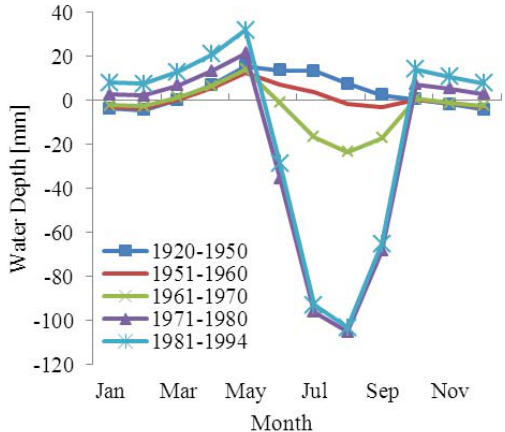
Fig. 8. Monthly aquifer storage change averaged by decades (stor- age change before the 1950s is not simulated in this model and is adapted from the